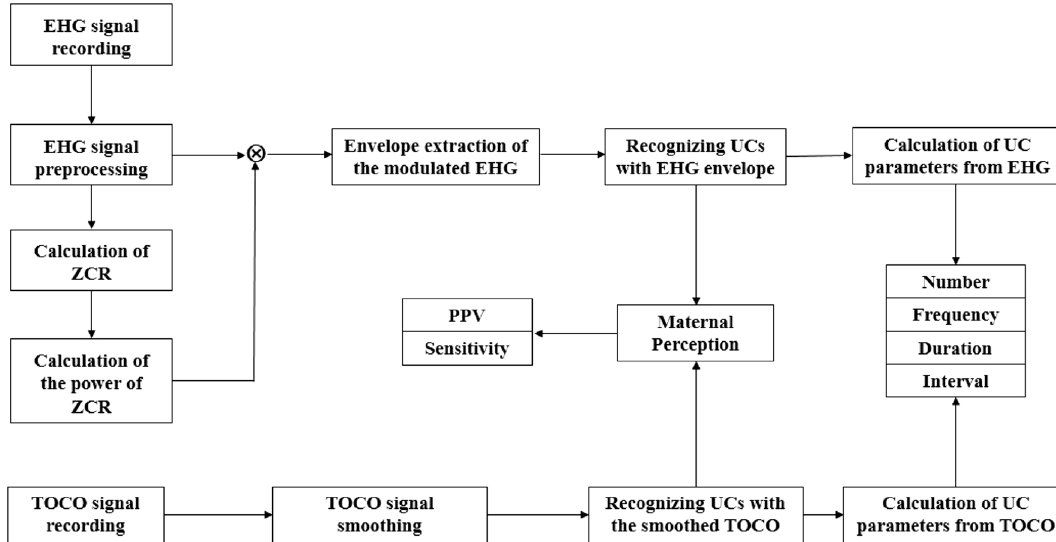
Figure 3. Block diagram of recognition and evaluation of UCs with EHG and TOCO.